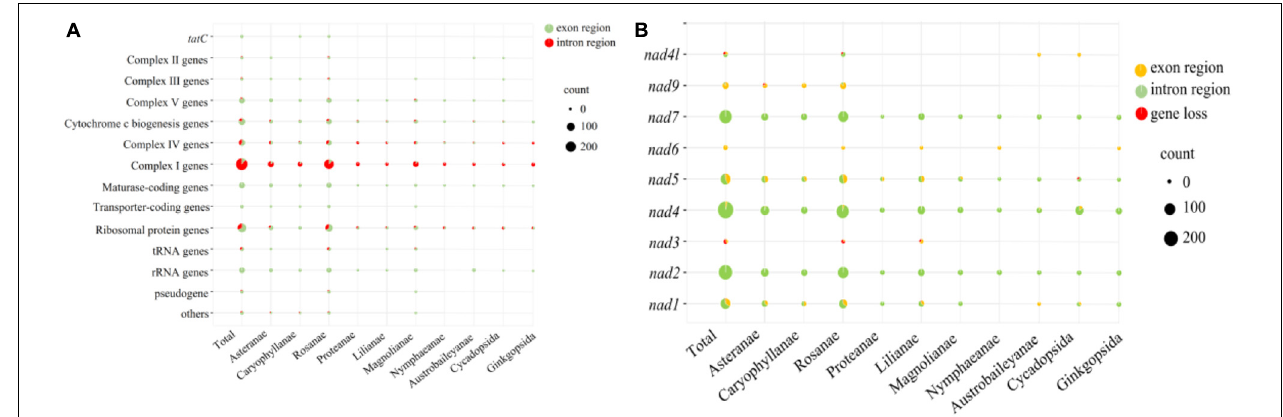
FIGURE 8 | Bubble diagram showing the number of SSRs located in the genic region (A) and nad - regions (B) .